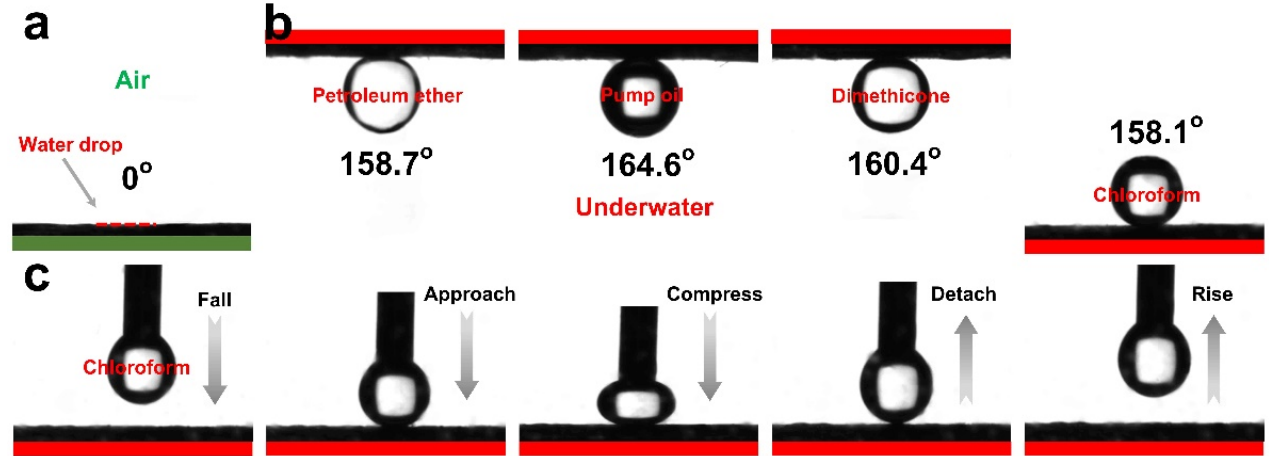
Figure 4. Contact angle measurement of THPC@TCNF membranes with respect to wettability. Photograph of a water drop in air ( a ), underwater various types of oil drops on THPC@TCNF membranes ( b ). Dynamic approach-compress-detach oil-adhesion test photograph for THPC@TCNF membrane ( c ).